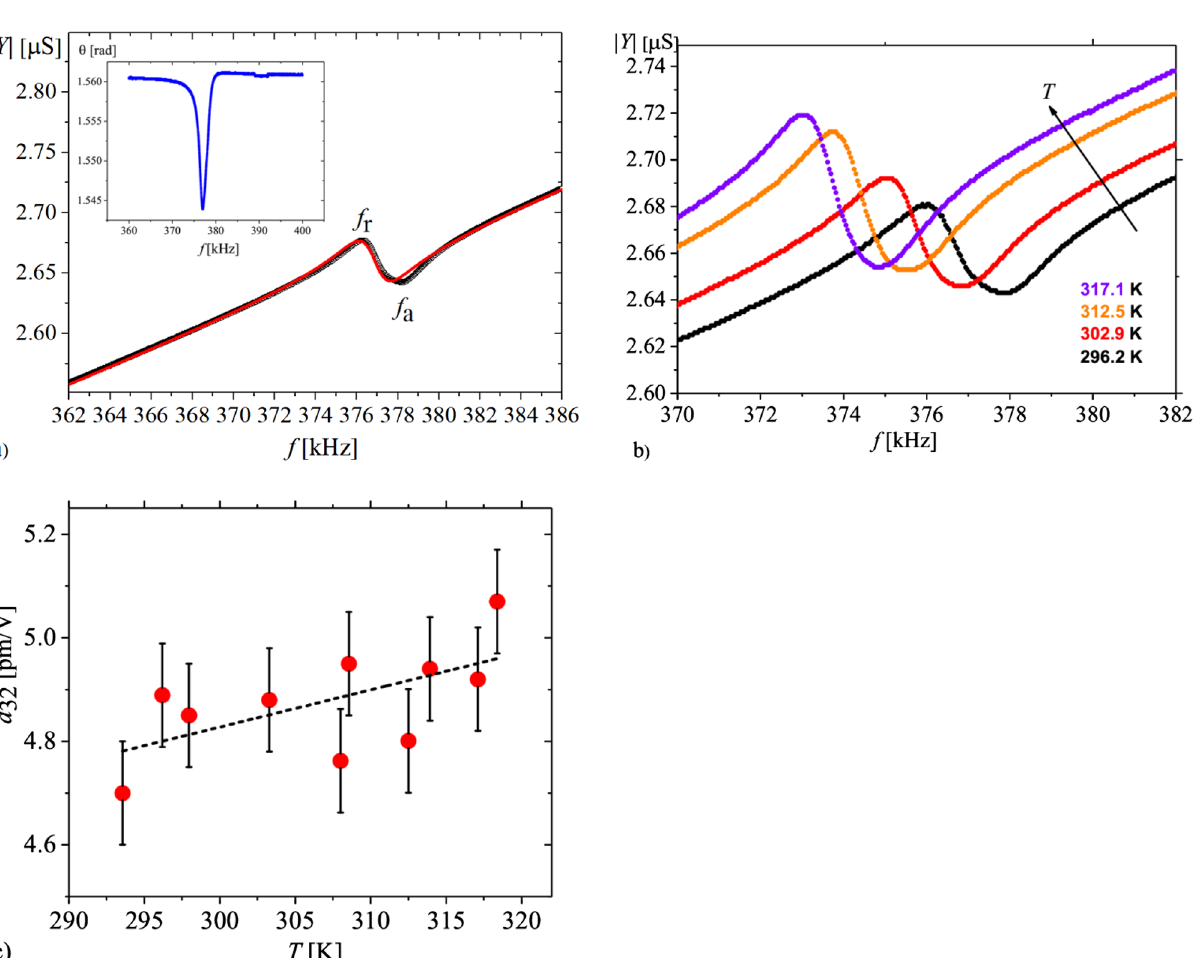
Figure 3. ( a ) Piezoelectric signal at 293 K, with characteristic dependence of admittance | Y | near piezoelectric resonance f r and antiresonance f a . The red line represents fit to experimental data based on the model described in Ref. 30 . The inset represents changes of phase shift θ in the relationship Y = | Y | e iθ . ( b ) The temperature evolution of piezoelectric resonances shows a shift of resonances towards lower frequencies with increasing temperature. All dependencies in Figs. a and b have been obtained for the strength of the measuring field amounting to 0.035 V/cm. c ) d 32 piezoelectric coefficient in a function of temperature in low temperature range. Standard deviation for each measuring point is shown. The dashed black line is the linear fit to the measurement points showing a weak increase in d 32 with